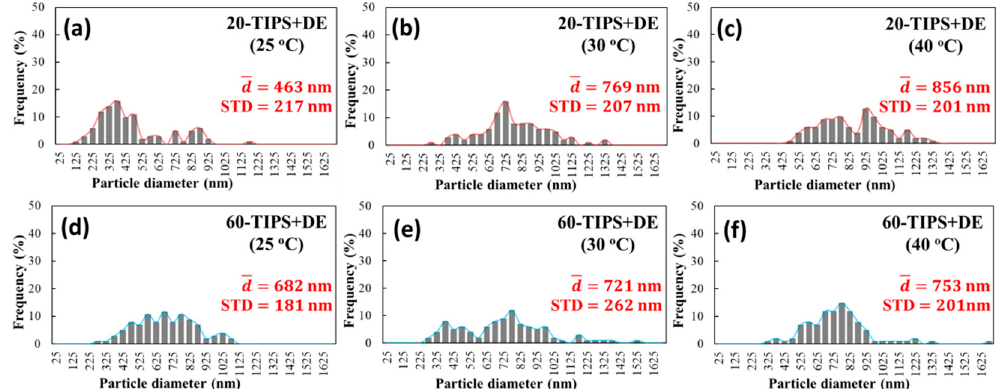
Figure 7. Particle size distribution of ( a – c ) 20-TIPS + DE samples and ( d – f ) 60-TIPS + DE samples at different evaporation temperature.